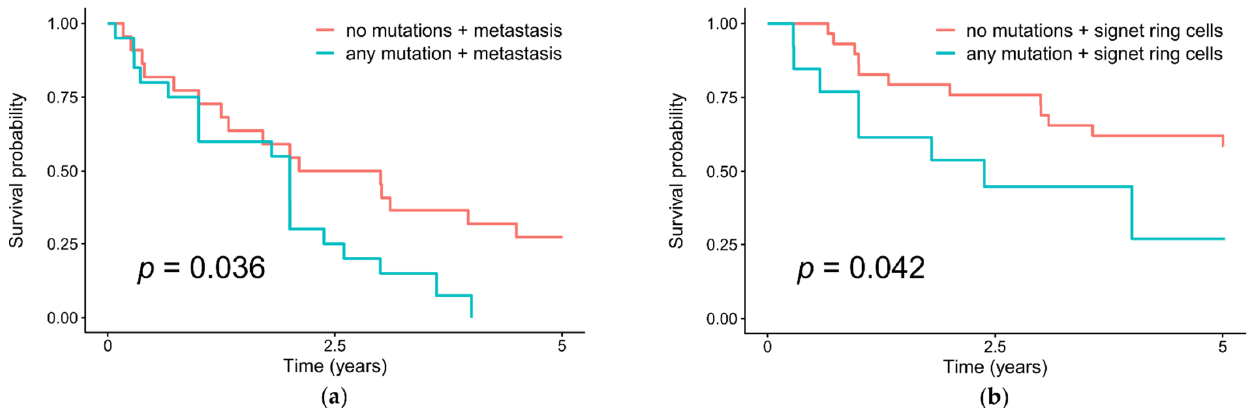
Figure 2. Overall survival in patients with and without somatic mutations of the epigenetic regulation genes in their gastric tumors, and ( a ) with distant metastases; ( b ) with the presence of signet ring cells in tumors.